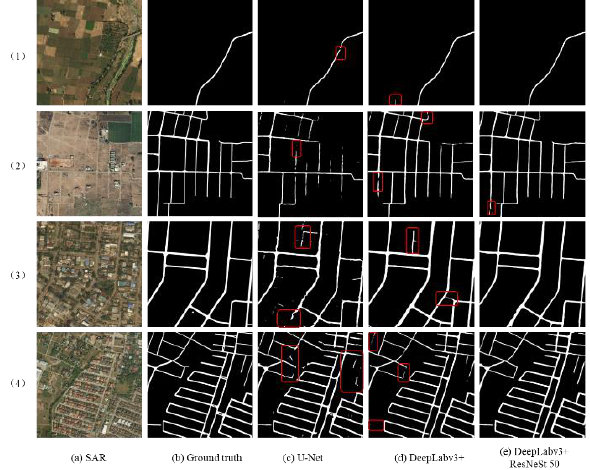
Figure 6 . The visualization of results on the DeepGlobe test set